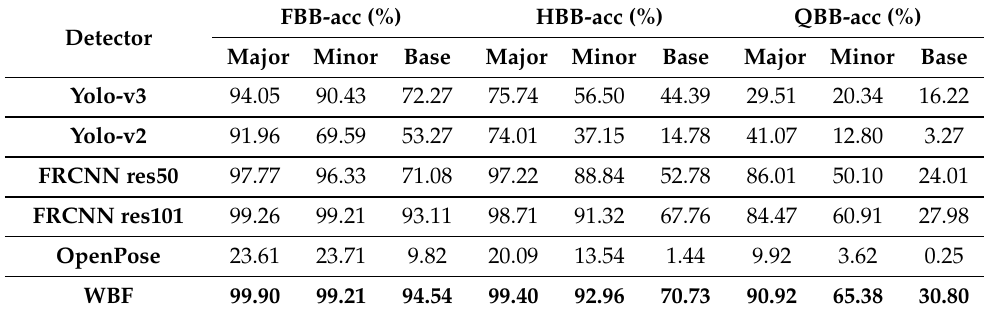
Table 6. Cross-dataset evaluation of HD dataset with model M